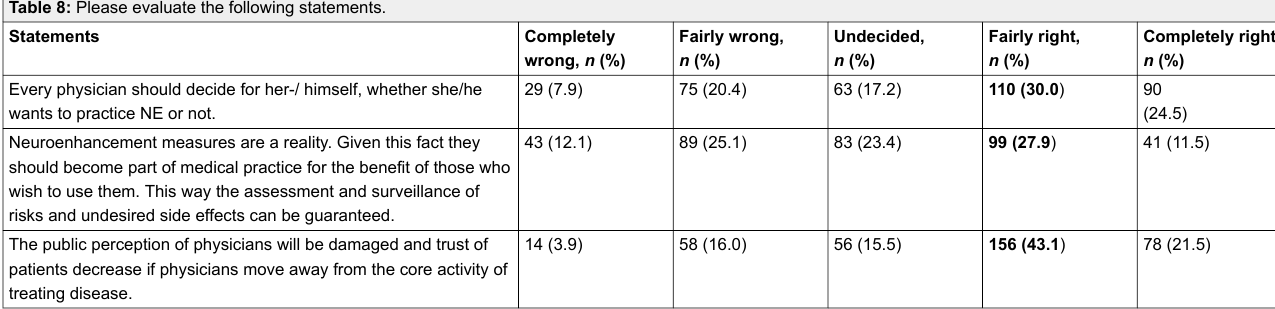
Table 8: Please evaluate the following